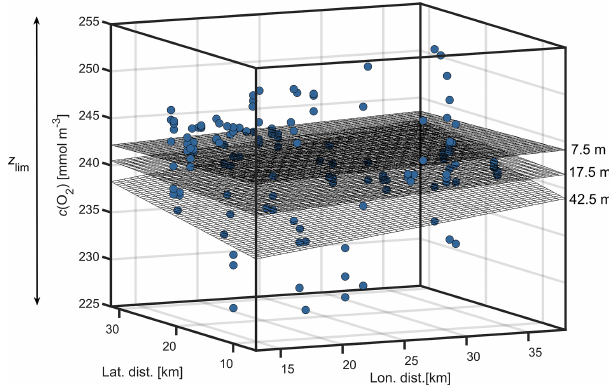
Figure 7. Plane fits of dissolved oxygen concentrations ( c( O 2 ) ) at 7.5, 17.5 and 42.5m depth within z lim for 25 March